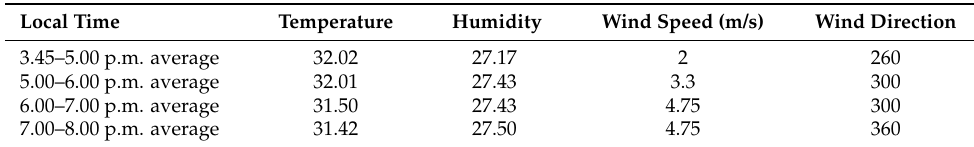
Table 5. Fuel-type-dependent input variable values.